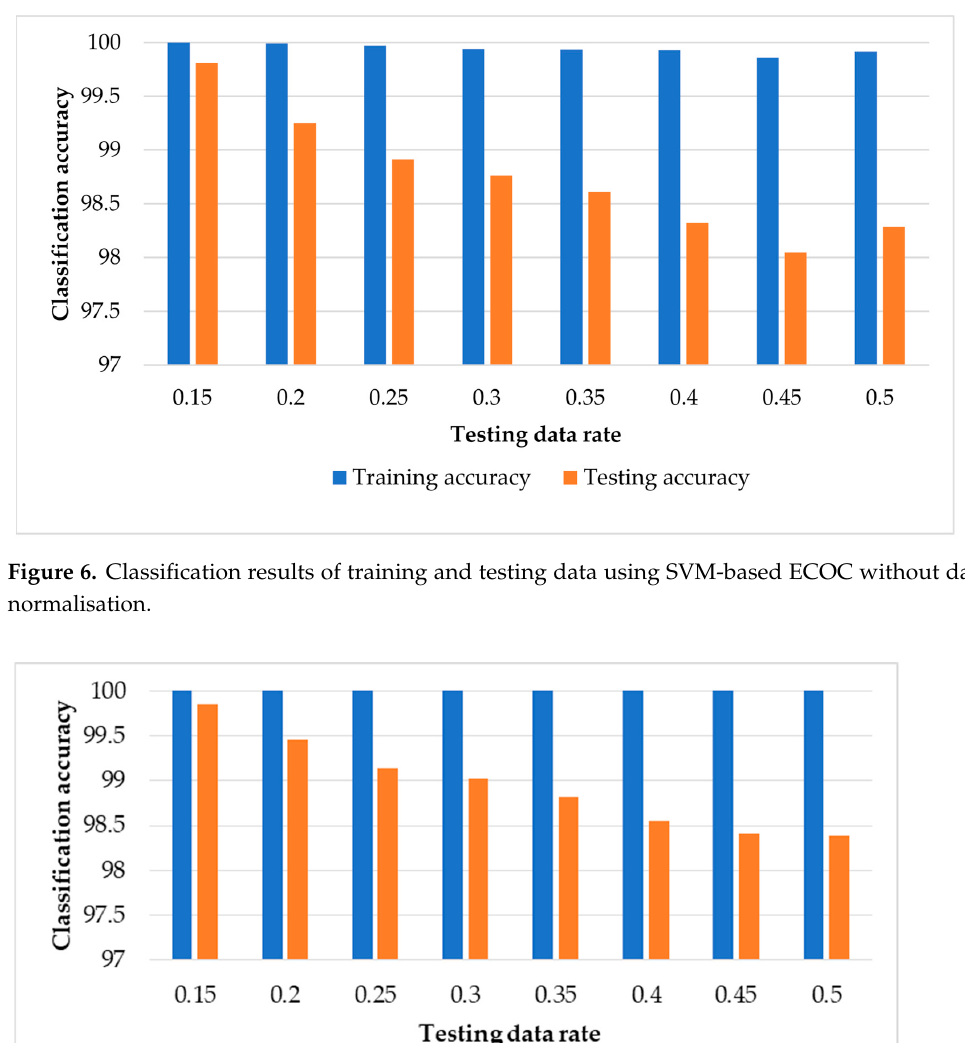
Table 5. Sample confusion matrix of the classification results of SVM-based ECOC with data nor-